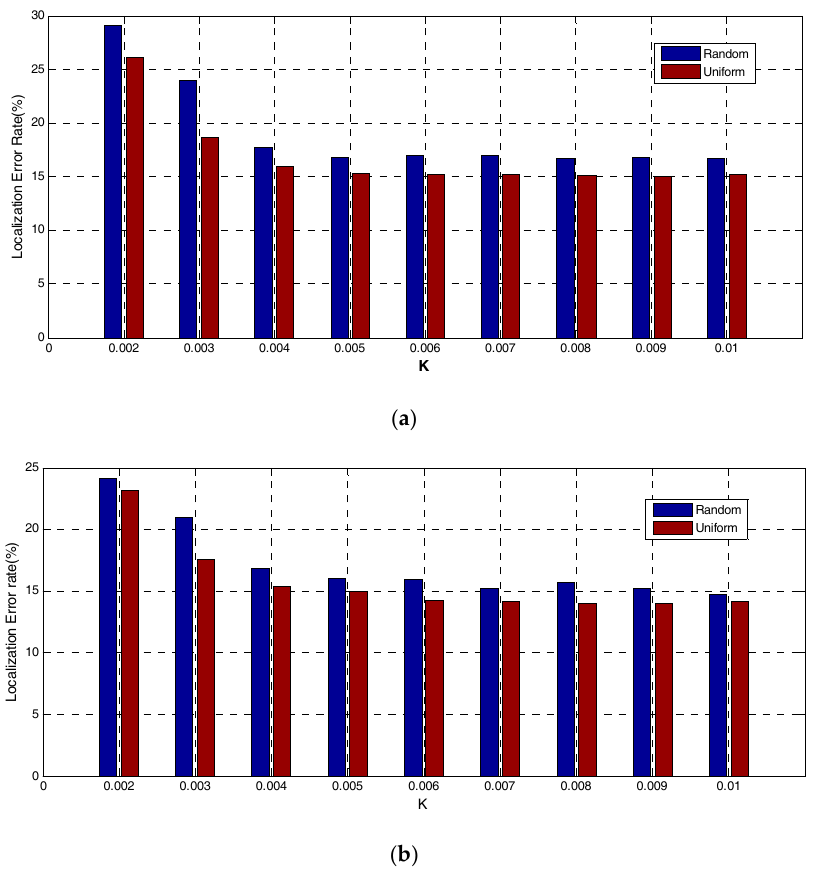
Figure 13. Localization Error Rate Varying with K. ( a ) AH = 3, AP = 20%, R = 450 m, K = 0.0020~0.01; ( b ) AH = 3, AP = 230%, R = 450 m, K = 0.0020~0.01.